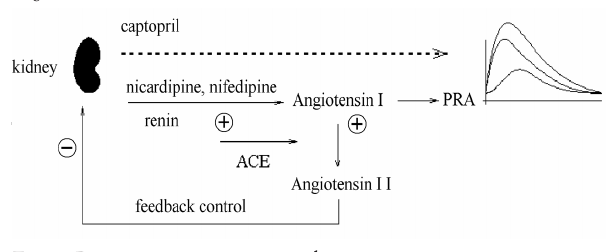
Fig. 1. Renin – angiotensin regulating system